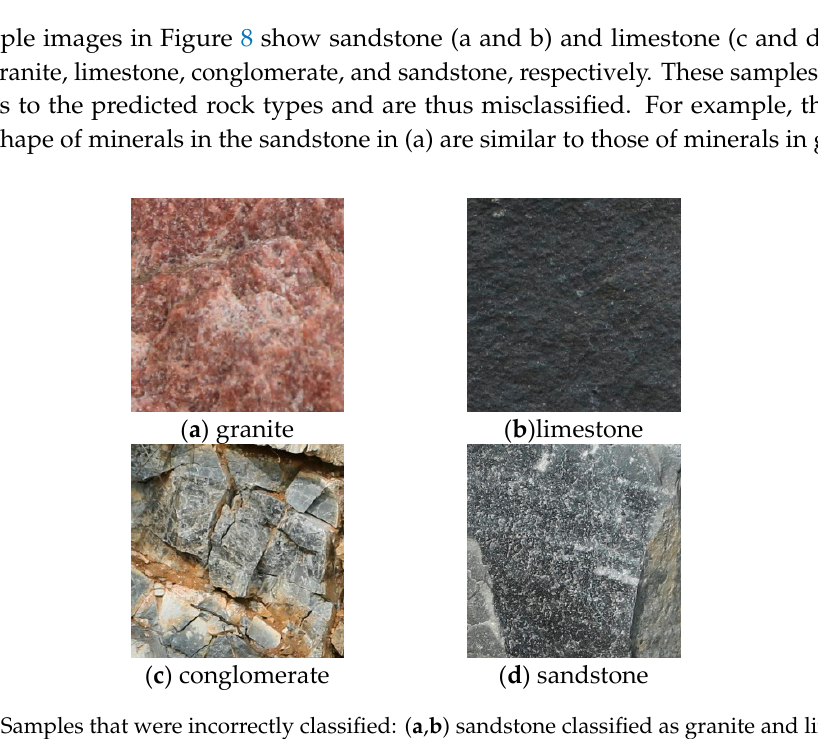
Figure 8. Samples that were incorrectly classified: ( a , b ) sandstone classified as granite and limestone, respectively; ( c , d ) limestone classified as conglomerate and sandstone, respectively.